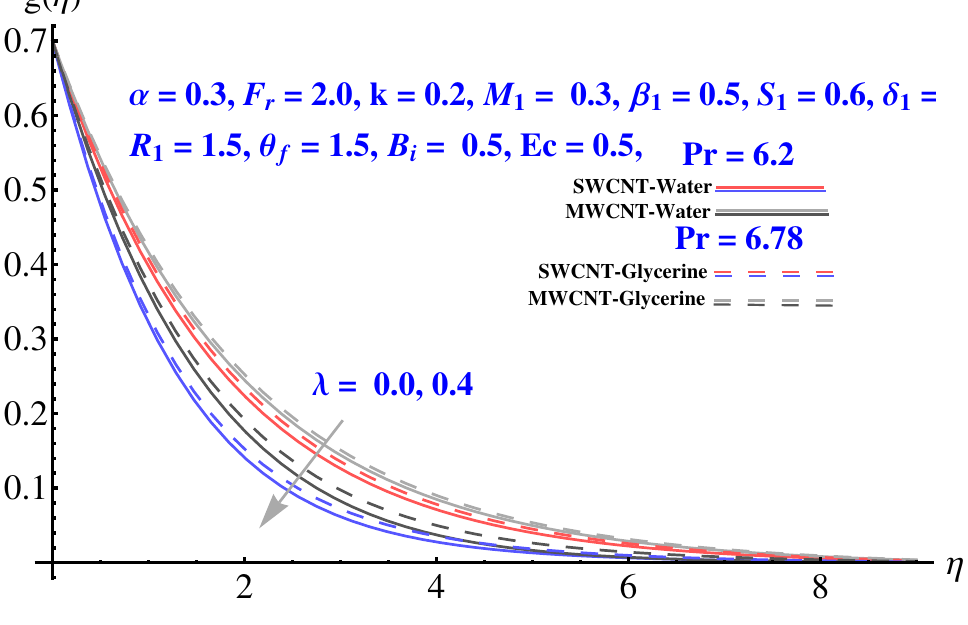
Figure 11. Impact of λ on tangential velocity.